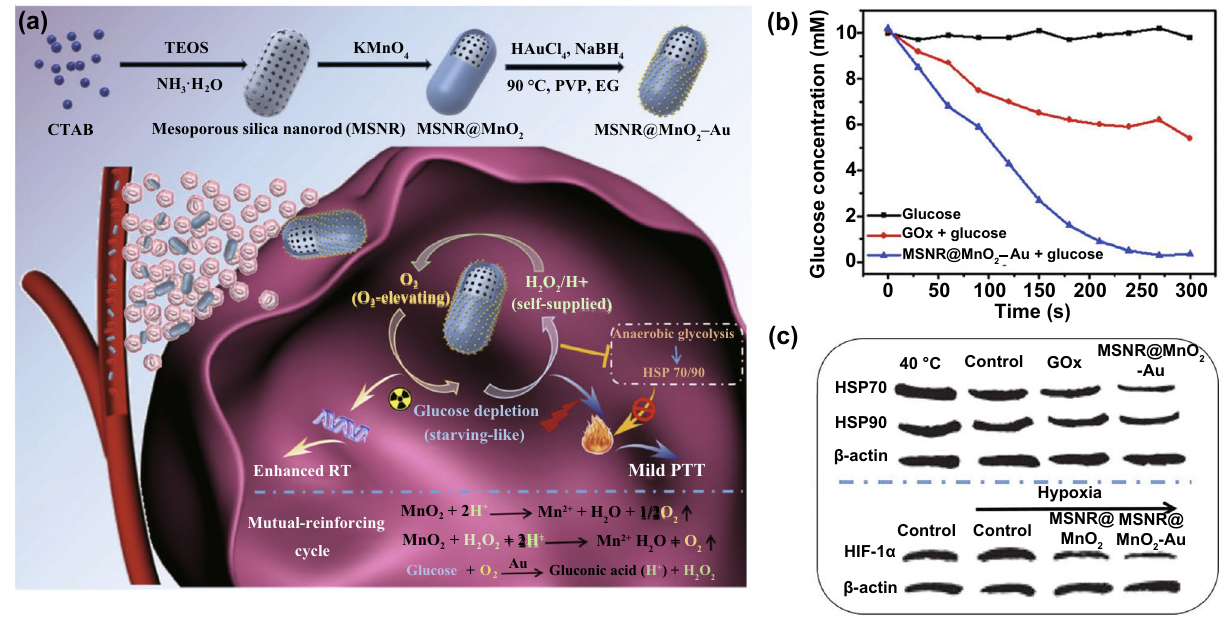
Fig. 11 a Schematic illustration for the preparation of MSNR@MnO 2 –Au for RT and starvation-promoted mild PTT. b Glucose consumption performance of MSNR@MnO 2 –Au. c Western blot images of HSP70, HSP90, and hypoxia-inducible factors-1α (HIF-1α) expression in MCF-7 cells treated with different formulations. Reproduced with permission from Ref. [132]. Copyright 2020, Tsinghua University Press and Springer- Verlag GmbH Germany, part of Springer